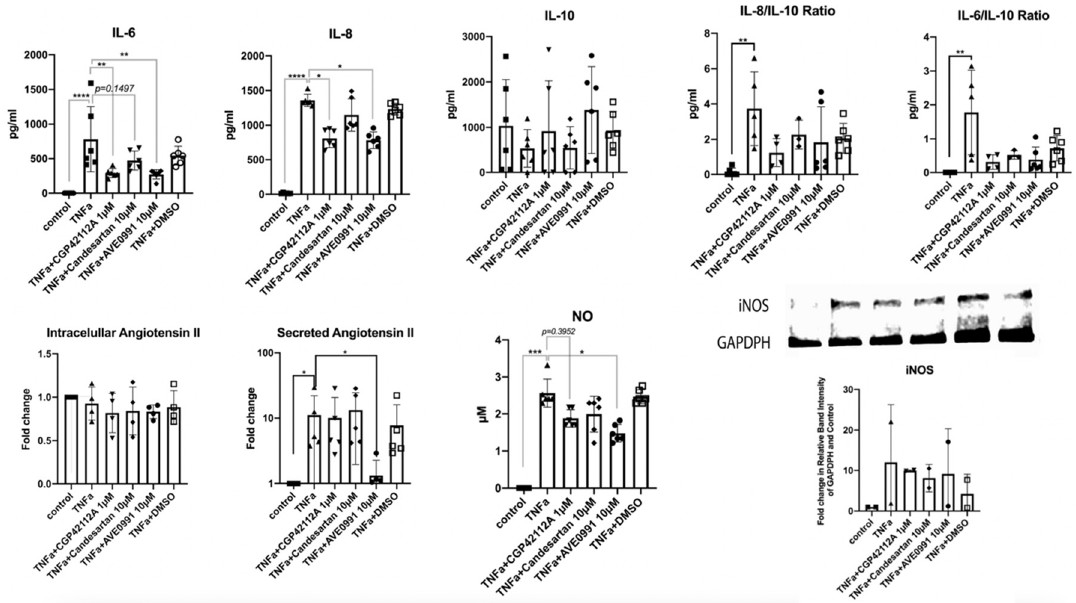
Figure 9. Protein alterations of IL-6, IL8, IL10, IL-8/IL-10 ratio, IL6-IL-10 ratio, as well as intracellular and secreted angiotensin II and iNOS in human nucleus pulposus cells after 24 h of exposure to candesartan (10 μ M), the MAS-receptor agonist AVE 0991 (10 μ M), and the AGTR2-receptor agonist CGP-42112A (1 μ M) in inflammatory settings (TNF- α addition). DMSO (1 μ L/mL) shown in μ L volume on the x -axis) was used as the solvent control. Fold change values are shown. For the iNOS analysis, fold change in relative band intensity of GAPDPH and control are shown. n = 3 biological replicates and n = 2 technical replicates per donor were assessed in the ELISA analysis. n = 2 biological replicates were assessed for the western blot analysis. ImageJ was used for Western blot quantification [37]. Mean and standard deviations (SD) are shown.* p < 0.05; ** p < 0.01; *** p < 0.001; **** p < 0.0001.